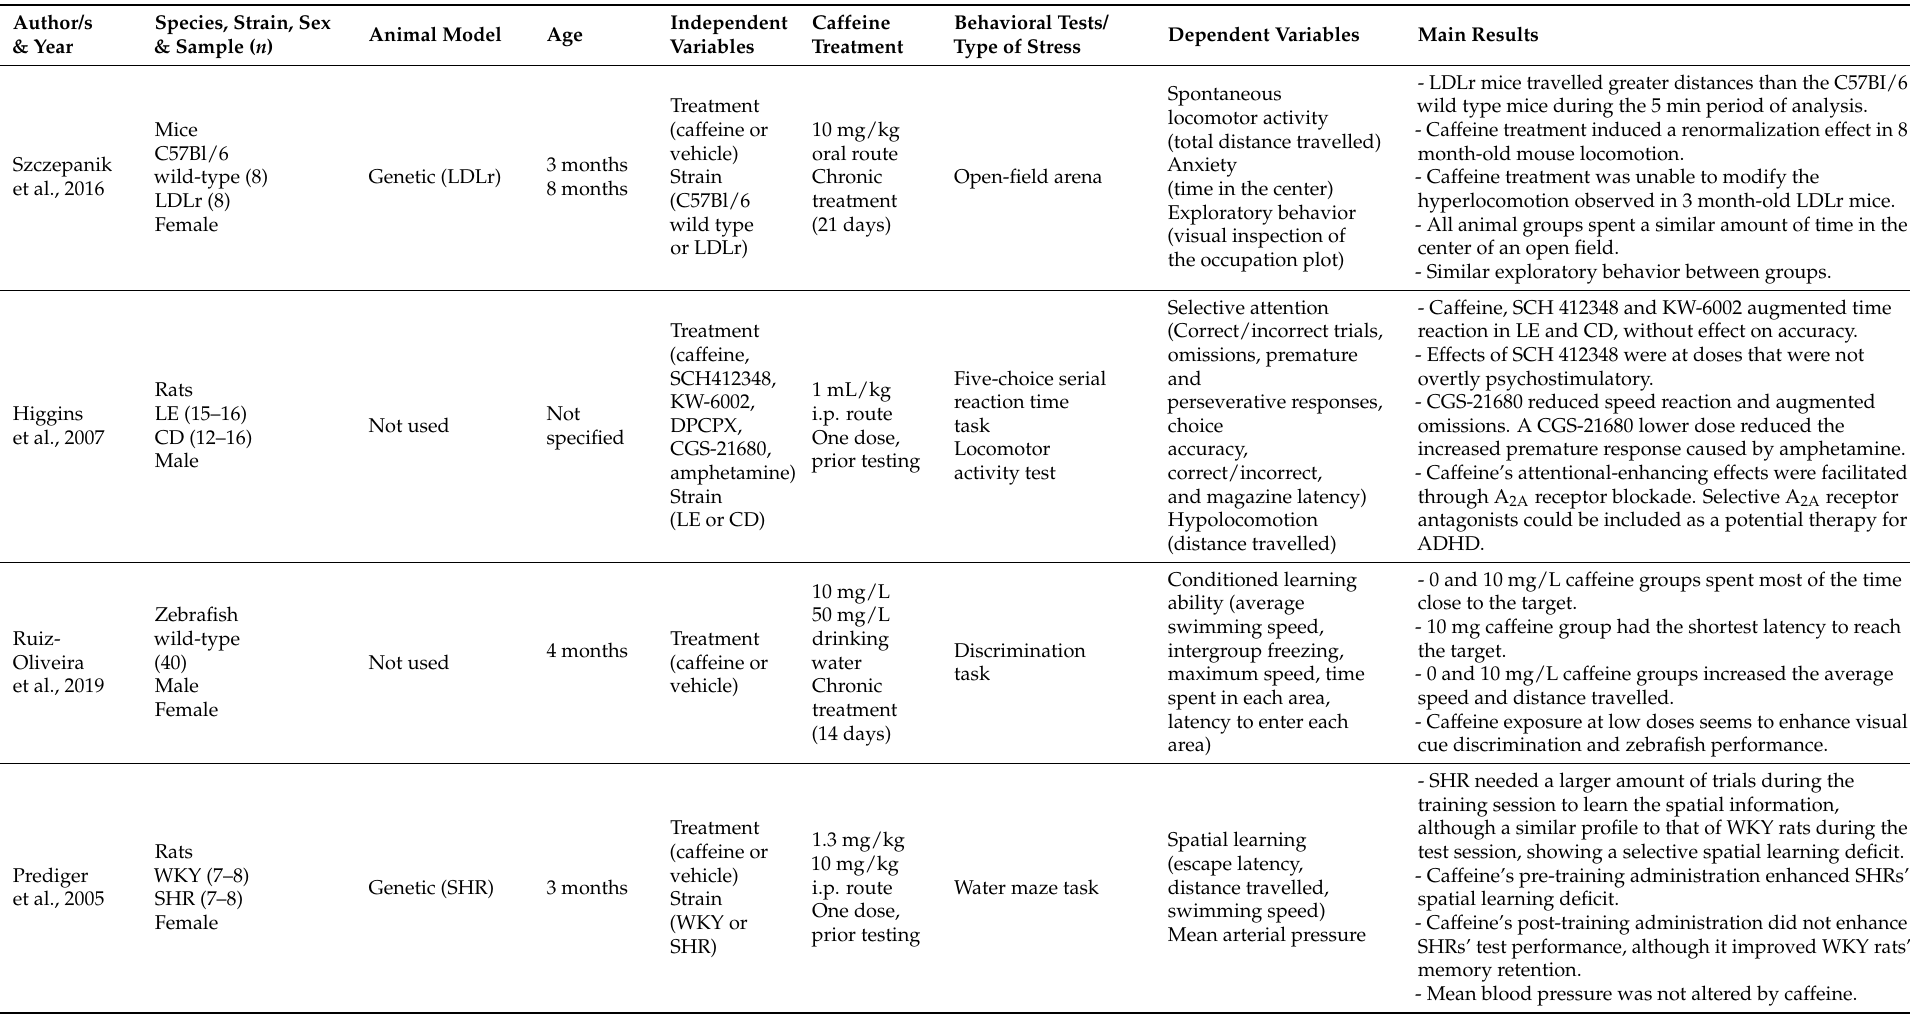
Table 1. Summary of included